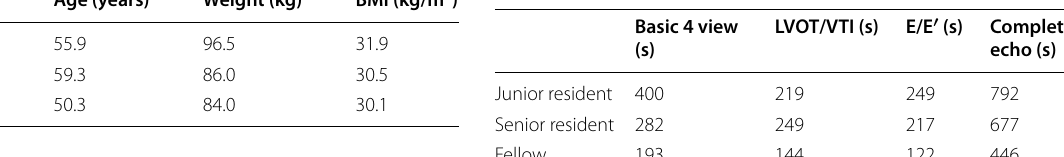
Table 1 Average patient characteristics